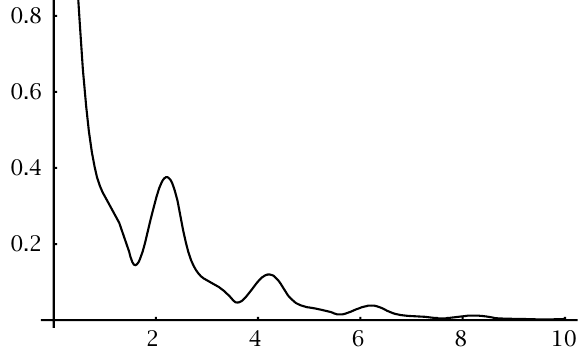
Figure 6.8 . T j (t) for b(t) = b cos (πt) , b = 3, d j =